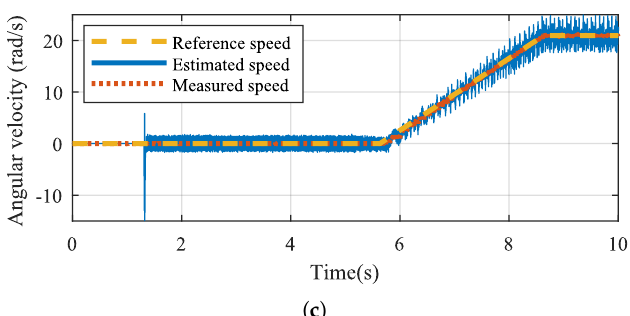
Figure 12. Experimental results using the traditional demodulation scheme. ( a ) Real (solid blue) and estimated (dashed orange) angles. ( b ) Estimation error. ( c ) Reference (dashed yellow), measured (dotted orange) and estimated (solid blue) speeds.